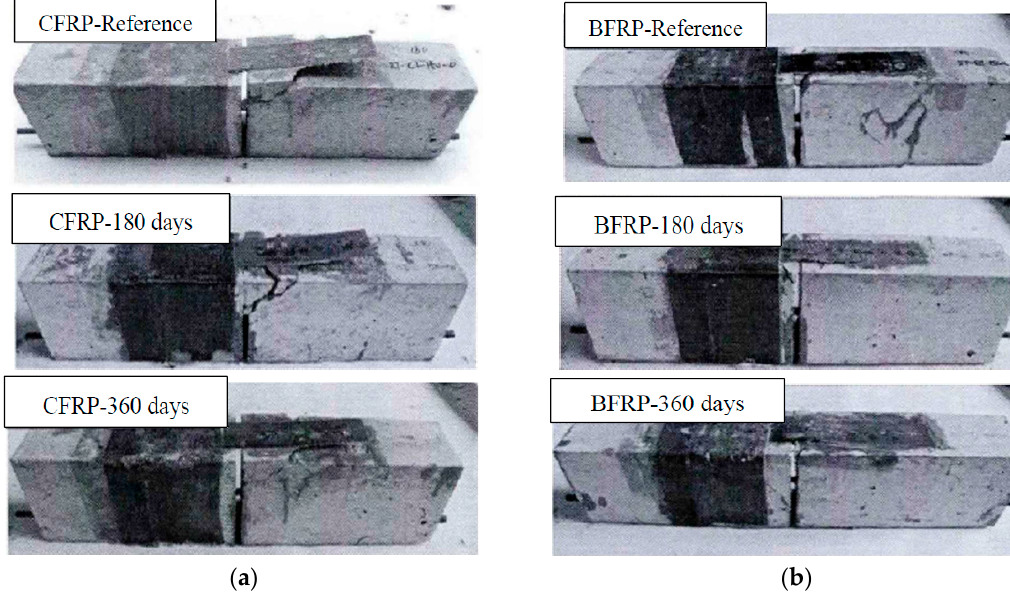
Figure 11. Failure modes of specimens. ( a ) Specimens with CFRP and ( b ) specimens with